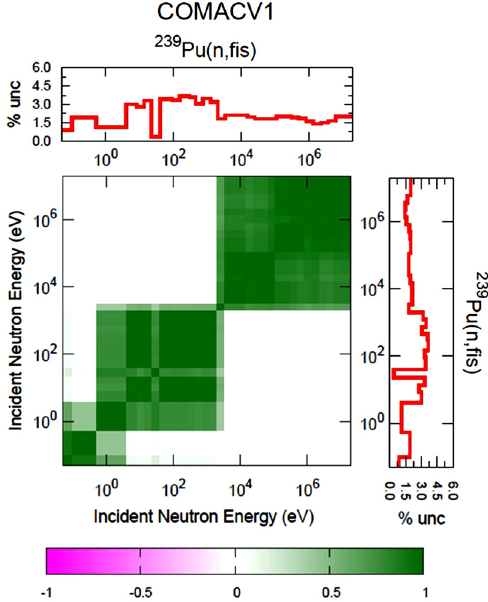
Fig. 2. 239 Pu fi ssion uncertainty and energy correlation: COMACV1.